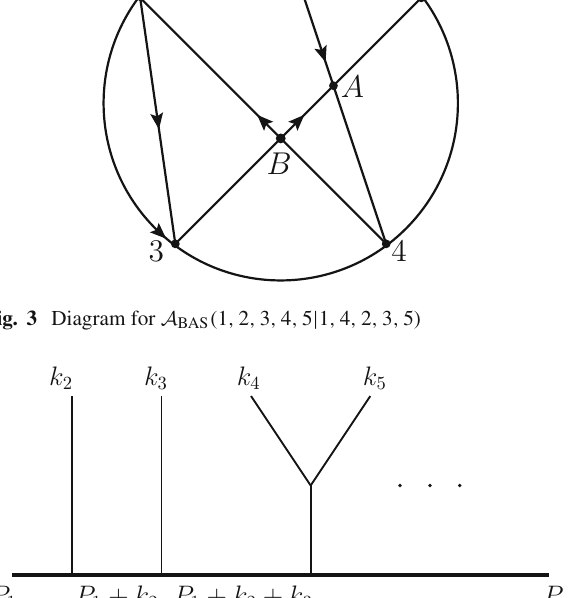
Fig. 4 Typical diagram for BAS amplitudes with two massive scalars, the bold line representing the massive